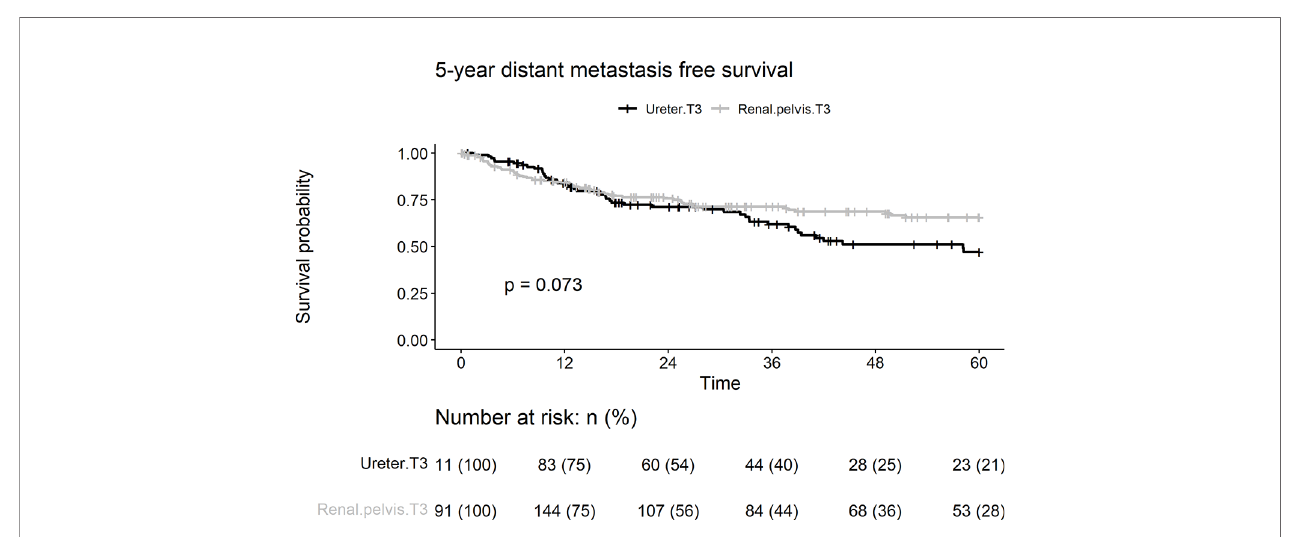
FIGURE 3 | Kaplan-Meier analyses for 5-year distant metastasis-free survival strati fi ed by tumor stage among patients with pT3N0M0 upper tract urothelial carcinoma following radical nephroureterectomy.